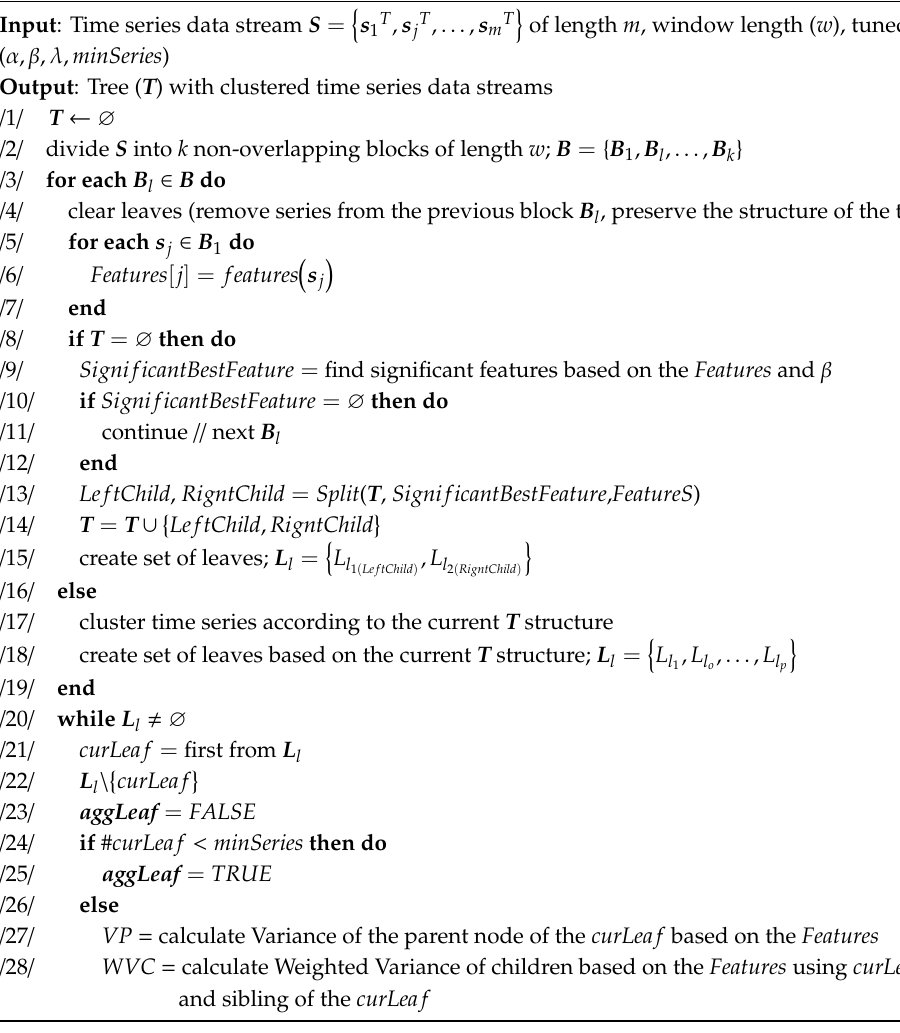
Algorithm 1: Clustering